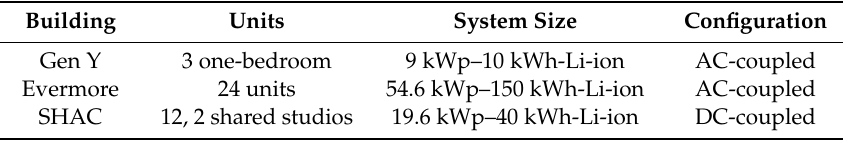
Table 1. White Gum Valley (WGV) apartment buildings and system